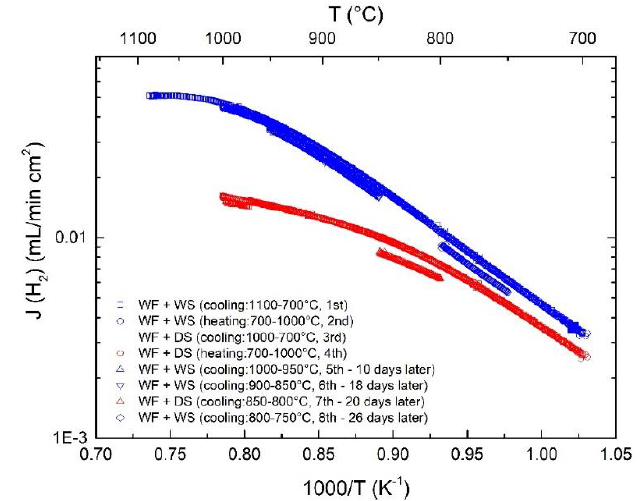
Figure 12. Apparent hydrogen flux as a function of the temperature measured during several heating and cooling cycles using both wet and dry sweeps. The feed side is wet 48.75% H 2 , and the sweep Ar flow is 25 mL/min.